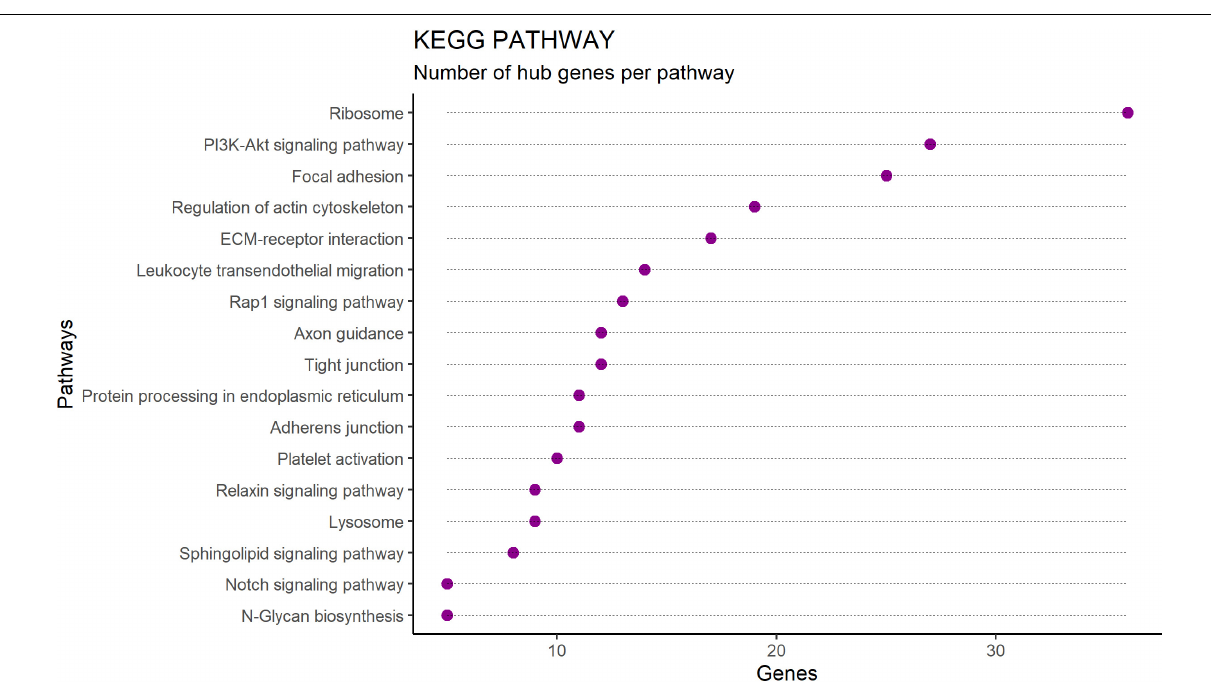
FIGURE 3 | Number of hub genes per pathway identified by enrichment analysis performed by ClueGO software on RNAseq data from Nelore Longissimus thoracis . Enriched pathways are shown on the Y -axis and the number of hub genes per pathway is shown on the X -axis.